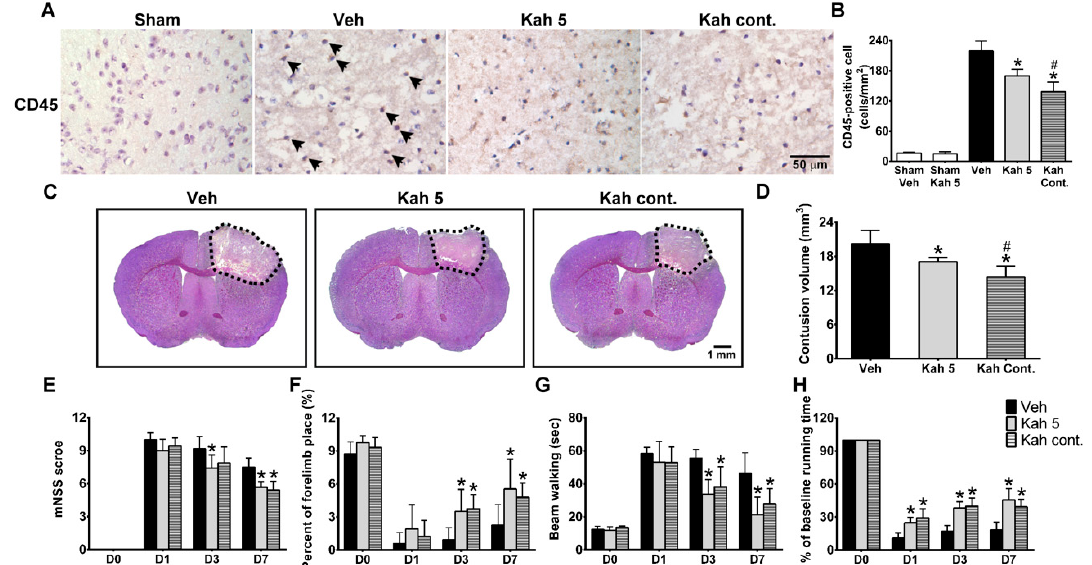
Figure 5. Multiple-dose kahweol treatment reduced brain injury in acute phase following TBI, but did not affect long-term neurobehavioral functions. ( A ) Representative IHC staining of leukocyte marker CD45 in the sham-injured, Veh-treated, and Kah 5- and Kah cont.-treated TBI animals. Scale bar = 50 µm. ( B ) Quantification of CD45-positive cells showed that increased levels of leukocyte infiltration in the Veh-treated group (compared versus sham-injured group) were markedly reduced in Kah 5-treated animals at three days post-injury. Multiple-dose Kah treatment further attenuated leukocyte infiltration compared to single-dose treatment in acute phase following injury. n = 3 per group. * p < 0.05 versus the Veh group. # p < 0.05 versus Kah 5 group. ( C ) Representative cresyl violet-stained brain sections of Veh-, Kah 5-, and Kah cont.-treated animals at day 3 following TBI. Dotted area indicates the contusion region in the ipsilateral cortex. Scale bar = 1 mm. ( D ) Continuous treatment of Kah further reduced contusion volume in the Kah cont. group compared to the Kah 5 group at day 3 post-injury. n = 6 for Veh group and n = 5 for Kah 5 and Kah cont. groups. * p < 0.05 versus the Veh group. # p < 0.05 versus Kah 5 group. Kah cont. treatment reduced ( E ) modified neurological severity score (mNSS) at day 7 post-injury, improved the ( F ) forelimb functions at days 3 and 7, reduced the ( G ) beam walk latencies at days 3 and 7, and improved the ( H ) rotarod performance at days 1, 3, and 7 compared to vehicle post-injury. However, there were no significant differences in neurobehavioral outcomes between the Kah 5- and Kah cont.-treated groups. n = 6 to 12 per group. * p < 0.05 versus the Veh group. Throughout, the data are mean ± SD. Veh, vehicle; Kah 5, kahweol 5 mg/kg; Kah cont., multiple-dose kahweol.